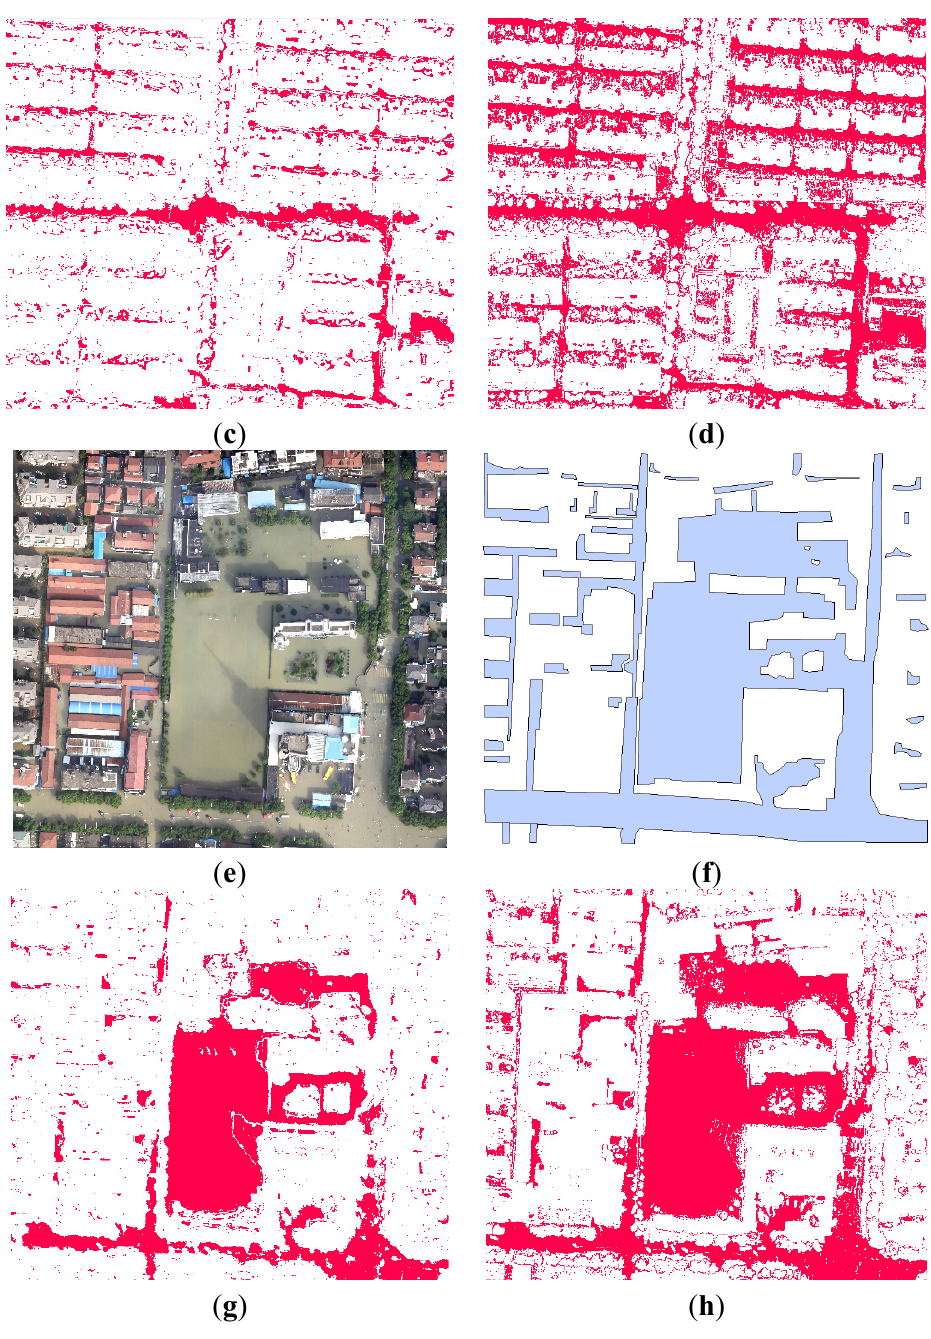
Figure 9. Image-A: ( a ) original RGB image; ( b ) digitized flooded areas; ( c ) extraction result of RGB-only; ( d ) extraction result of RGB + texture; Image-B: ( e ) original RGB image; ( f ) digitized flooded areas; ( g ) extraction result of RGB-only; ( h ) extraction result of RGB +